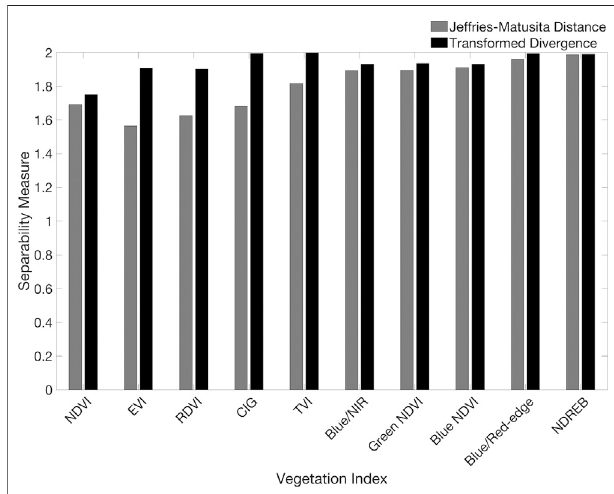
FIGURE 7 | JM and TD values for the 10 red-edge or NIR-based vegetation indices, with 0 being no separability between classes and 2 being complete